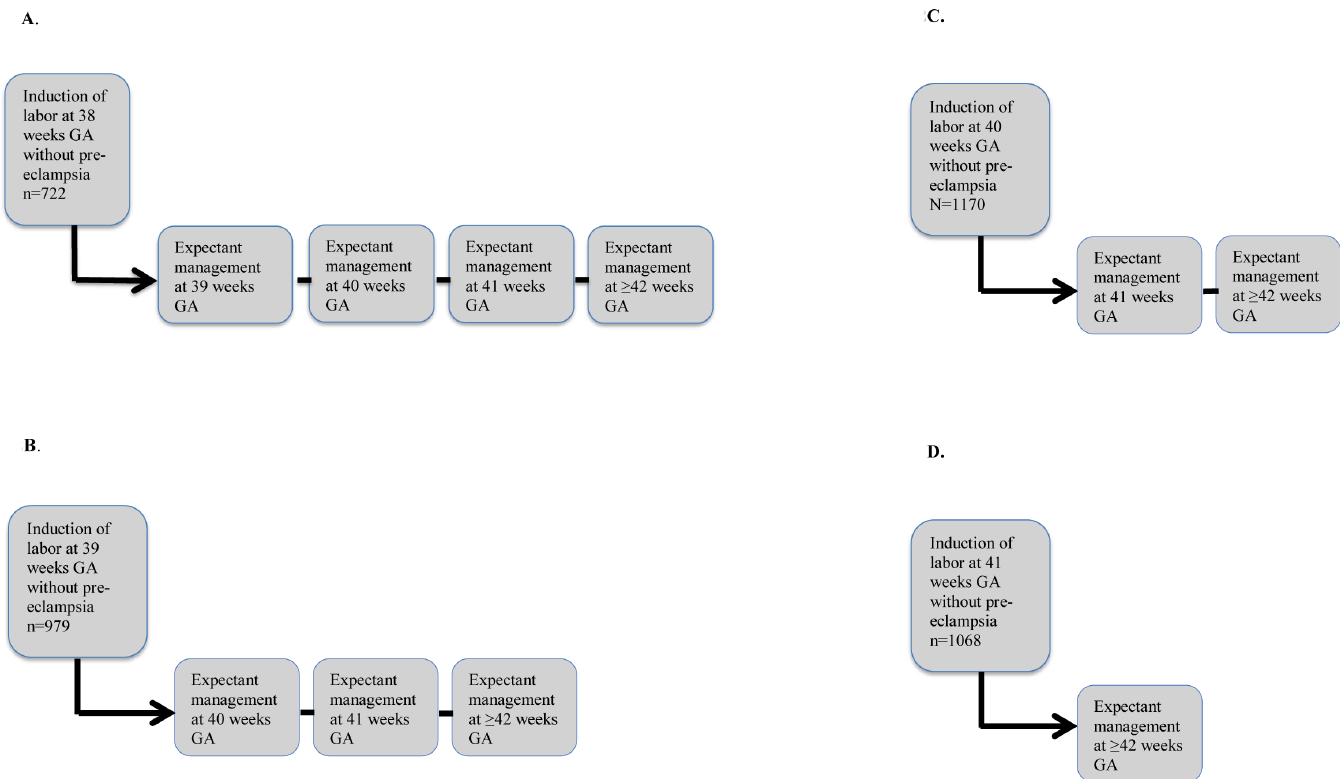
Fig 2. Study comparison groups: Women with LGA infants who underwent induction of labor at one given weeks of gestation were compared to women who similarly had LGA and delivered at a later gestation (at 39, 40, 41, or 42 weeks and beyond), by either spontaneous labor or induction of labor. Fig 2 A. Women with LGA infants who underwent inductionof labor at 38 weeks comparedto women who deliveredat 39, 40, 41, or 42 weeks and beyond. Fig 2 B. Women with LGA infants who underwent inductionof labor at 39 weeks comparedto women who deliveredat 40, 41, or 42 weeks and beyond. Fig 2 C. Women with LGA infants who underwent inductionof labor at 40 weeks comparedto women who deliveredat 41 or 42 weeks and beyond. Fig 2 D. Women with LGA infants who underwentinductionof labor at 41 weeks comparedto women who delivered at 42 weeks and beyond.